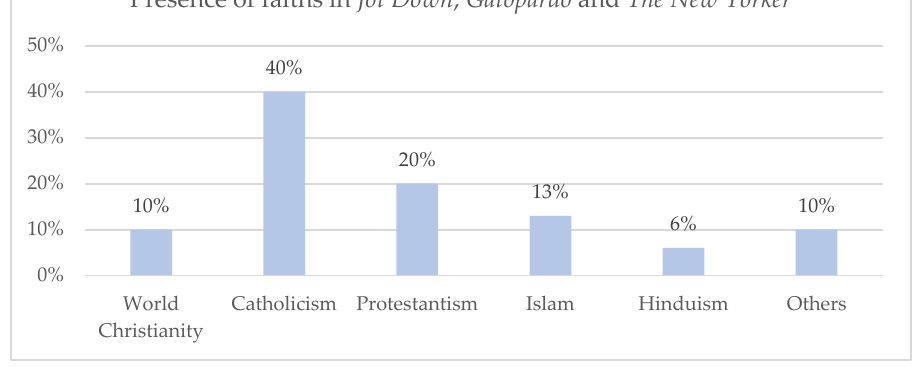
Figure 3. Presence of faiths in the articles analysed in Jot Down, Gatopardo, and The New Yorker .